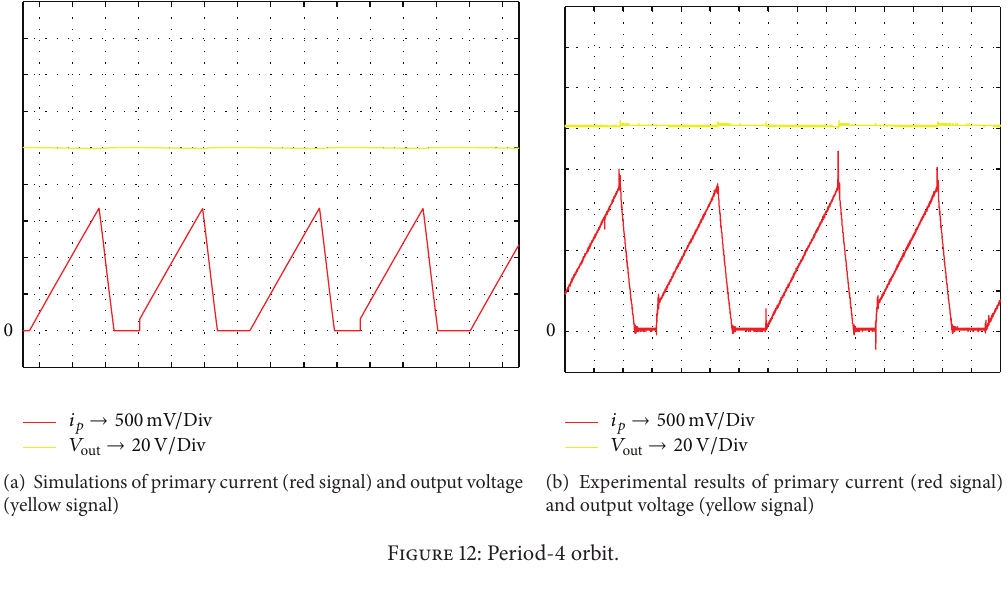
(b) Experimental results of primary current (red signal) and output voltage (yellow signal) Figure 12: Period-4 orbit.